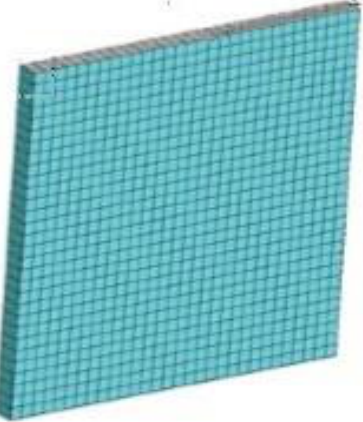
Figure 2. Detail of the door’s mesh.